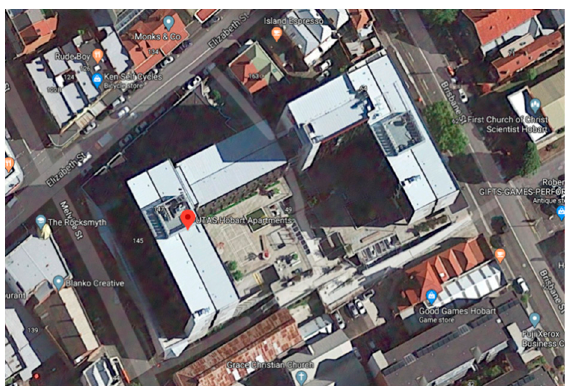
Figure 2. Aerial view of the student apartment complex and proposed garden sites [Google Maps].